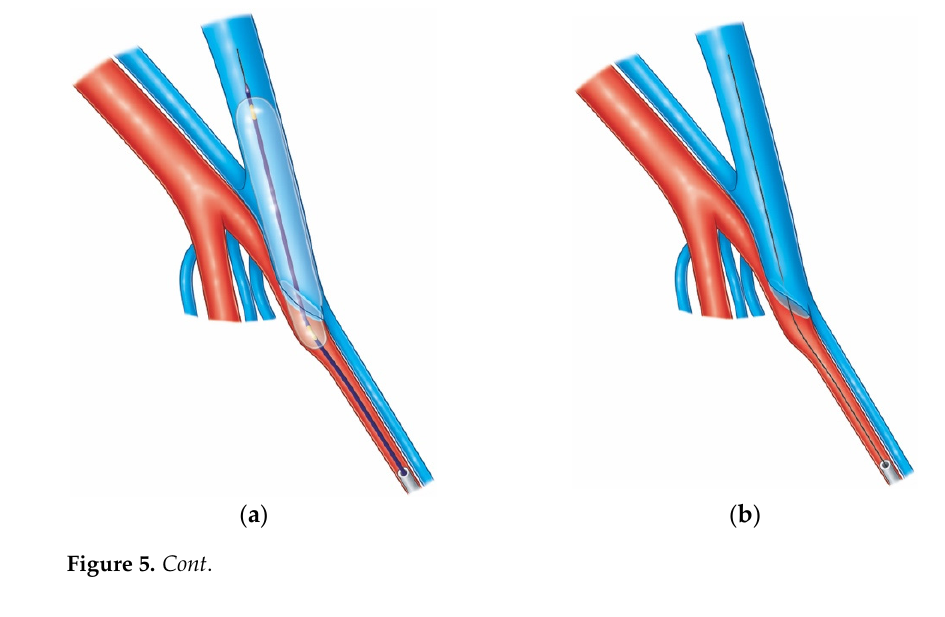
Figure 4. Algorithm for maintenance and assisted maturation for percutaneous fistula created with Ellipsys—reproduced with permission from Mallios et al. J Vasc Surg [20].